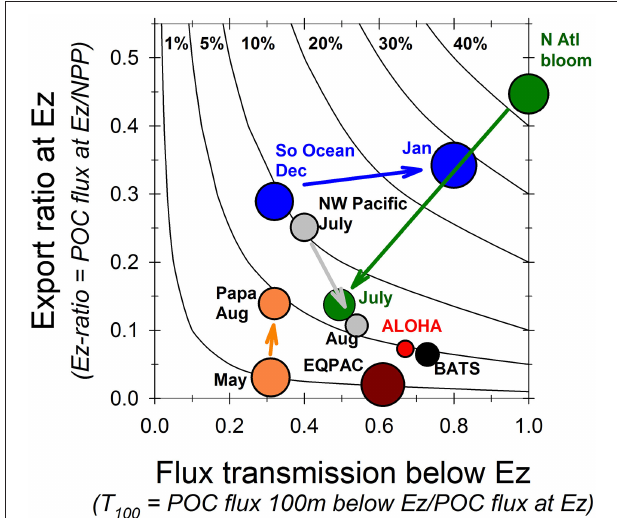
FIGURE 2 | Graphical depiction of the export and fate of upper ocean net primary production (NPP) energy. For each site and time, the ratio of NPP to POC flux at the depth of the euphotic zone (Y-axis) is compared to POC flux transmission through the first 100m below EZ (X-axis). The area of the circle is proportional to NPP (roughly 1000mg C m − 2 d − 1 at EQPAC) and the contour lines (1–40%) are the fraction of NPP that reaches 100m below the euphotic zone. Figure is adapted from Buesseler and Boyd (2009) and focuses on POC flux at the EZ and first 100m below, as this is where sinking POC flux differences are